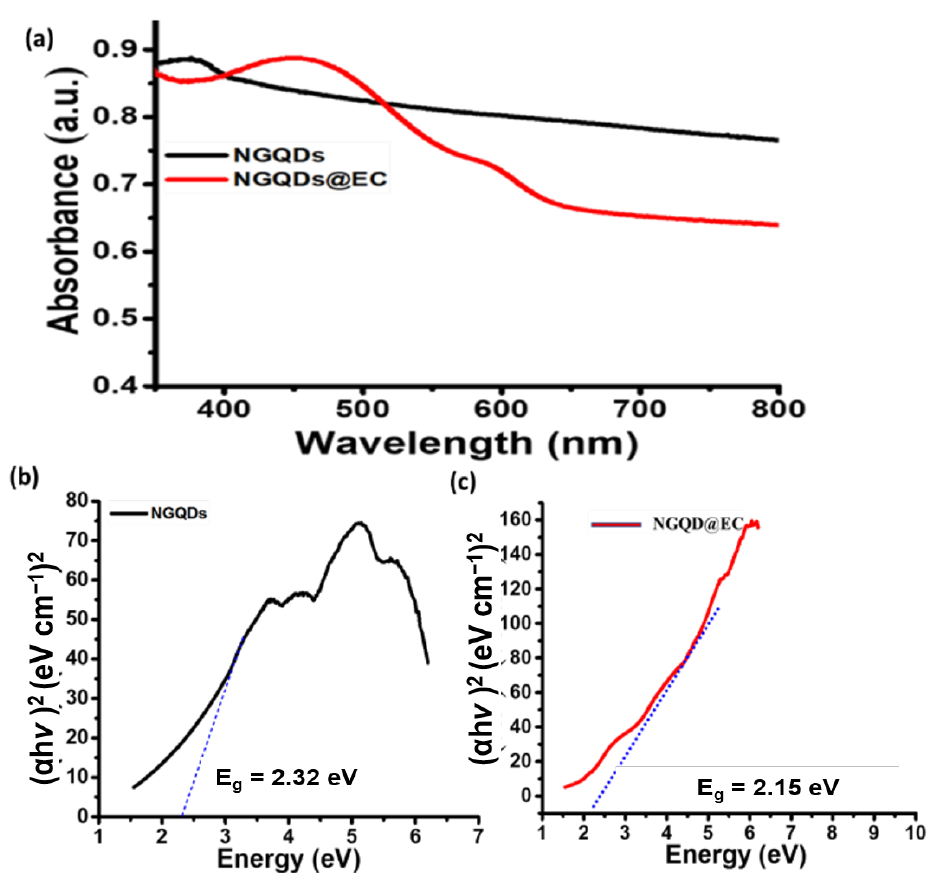
Figure 1. ( a ) UV–visible diffuse reflectance spectra (DRS) of NGQDs (black line) and NGQDs@EC (red line) photocatalyst, respectively, ( b ) Tauc plot of NGQDs, ( c ) Tauc plot of NGQDs@EC photocatalyst.